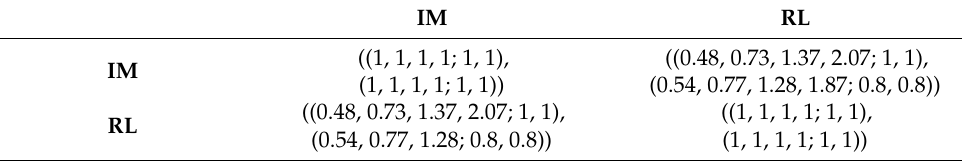
Table 5. Pairwise IT2F comparison matrix- Presence